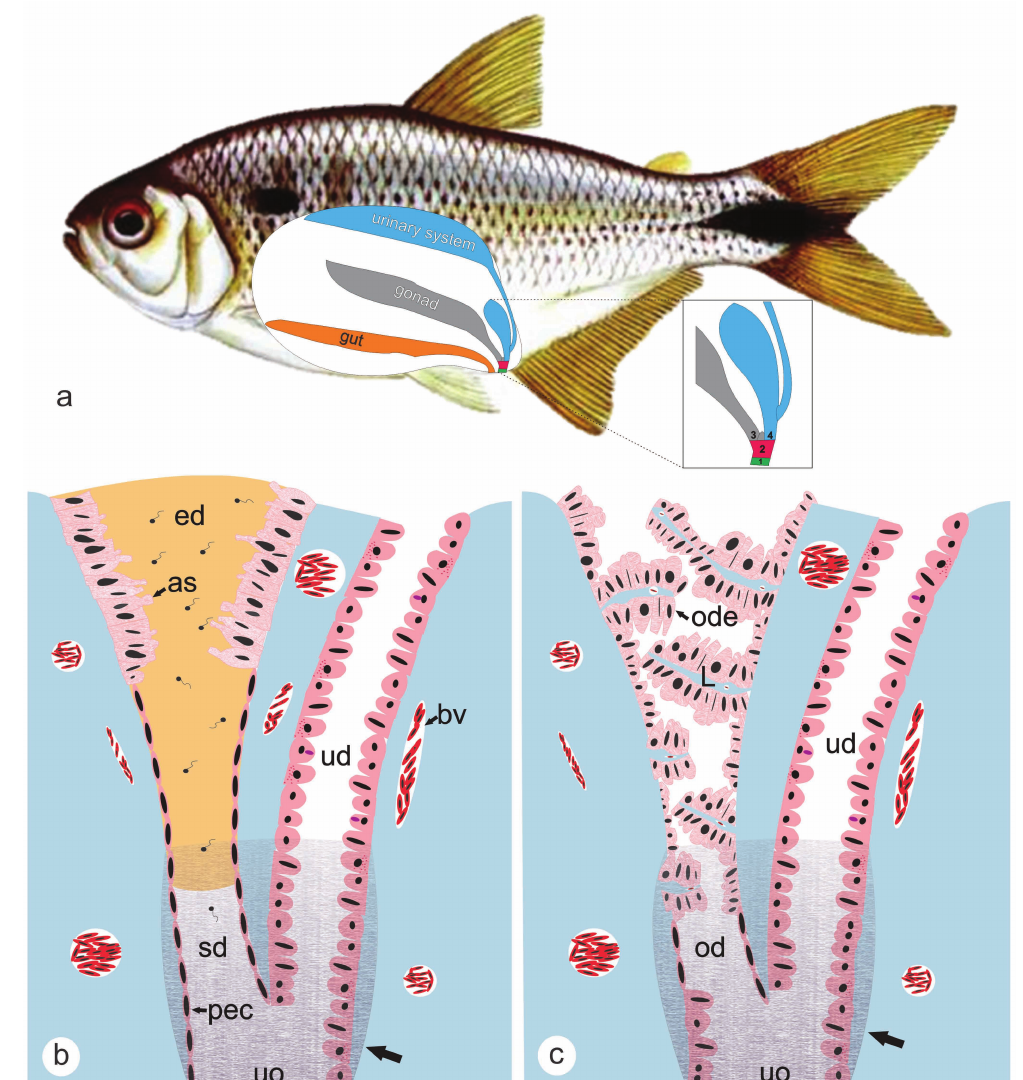
Fig. 4. Scheme of the urogenital papilla in Astyanax altiparanae . a) Position of the urogenital papilla in relation to fish body. 1 = urogenital opening; 2 = split of the urogenital duct in genital and urinary duct; 3 = genital duct; 4 = urinary duct. Fish image adapted from: causoeacasodepescador.blogspot.com.br: b) Structure of the urogenital papilla and its components ducts in males; c) Structure of the urogenital papilla and its components ducts in females. Abbreviations and symbols: as = cells with possible apocrine activity; bv = blood vessels; ed = efferent ducts; L = oviduct lamellae; ode = epithelial cells of the oviduct lamellae; sd = spermatic duct; ud = urinary duct; large arrow = striated skeletal muscle